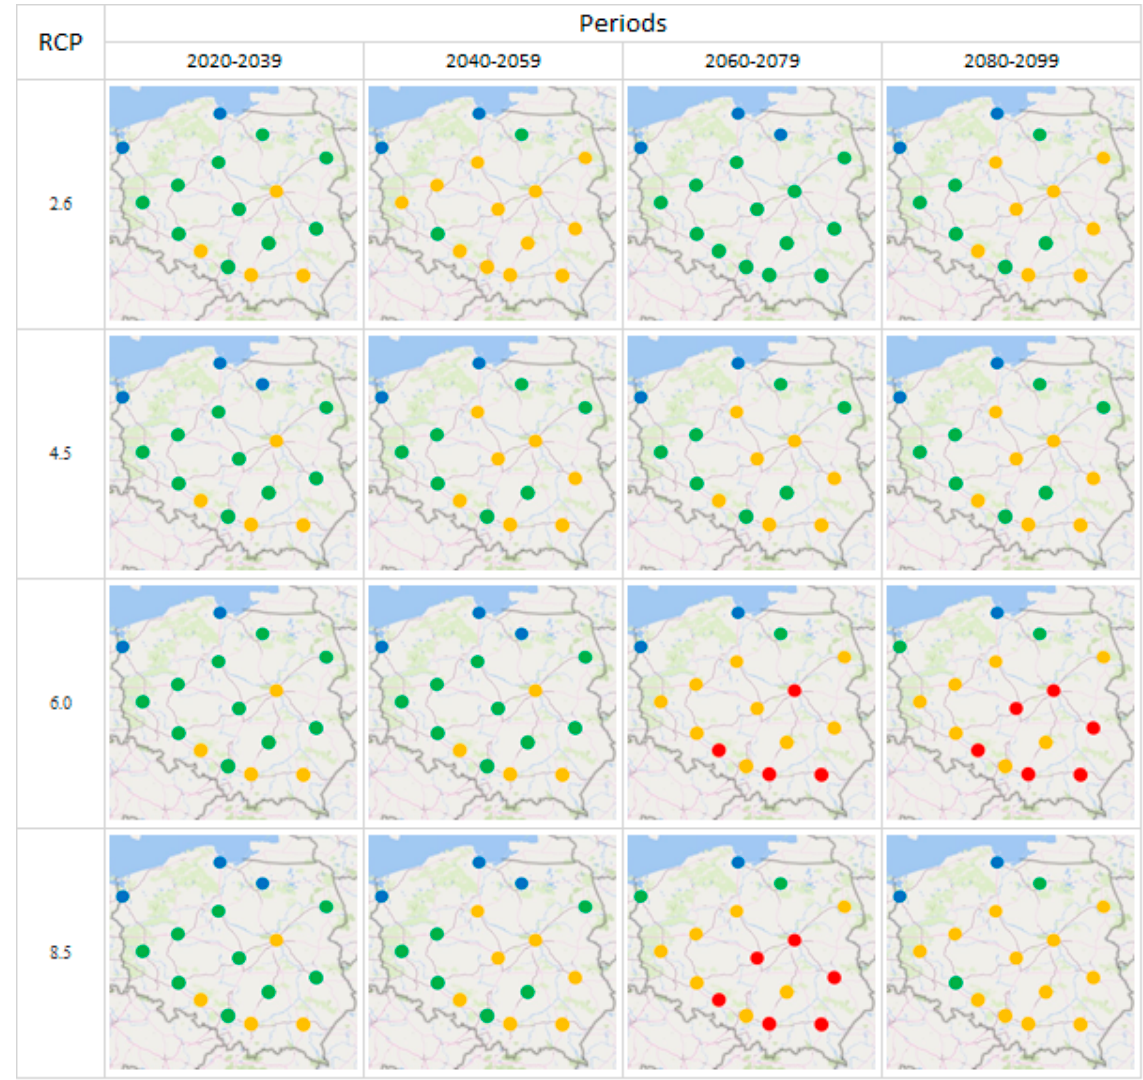
Figure 4. Results of clustering the locations according to the value of linolenic acid content for four RCP scenarios (2.6, 4.5, 6.0, 8.5) and four periods (2020–2039, 2040–2059, 2060–2079, 2080–2099). Locations in the same cluster are marked with the same color.